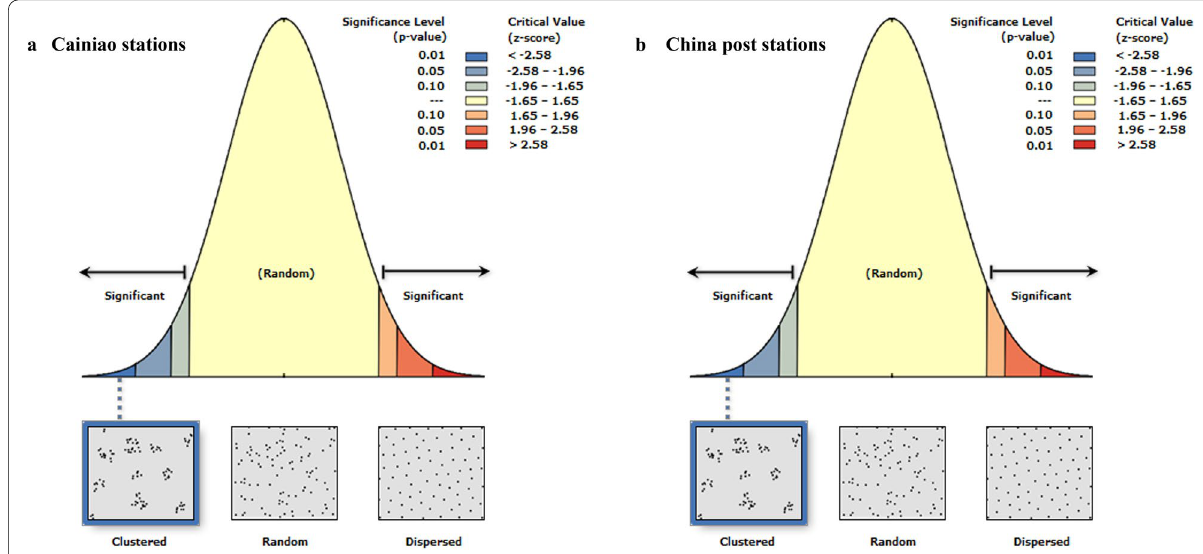
Fig. 3 Average nearest neighborhood analysis for CDPs